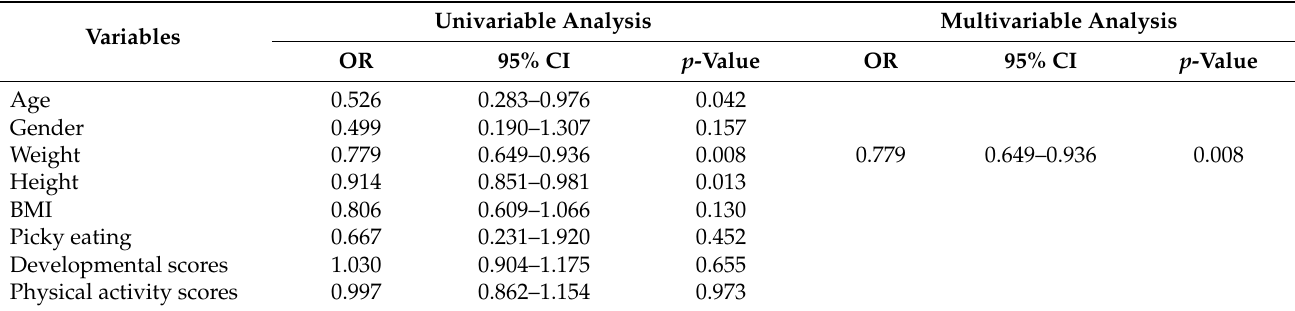
Table 10. Association of copper deficiency with demographics and clinical